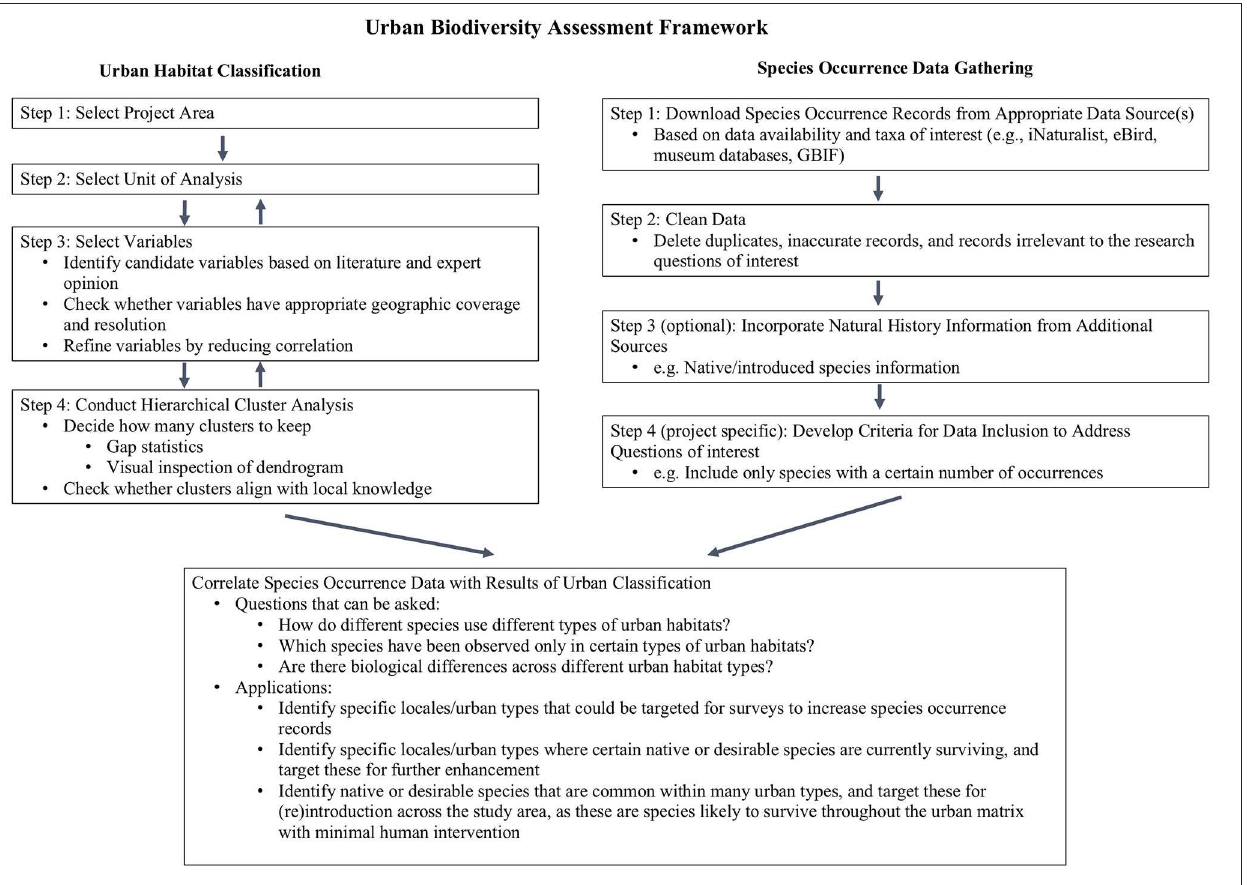
FIGURE 2 | Diagram of the urban biodiversity assessment